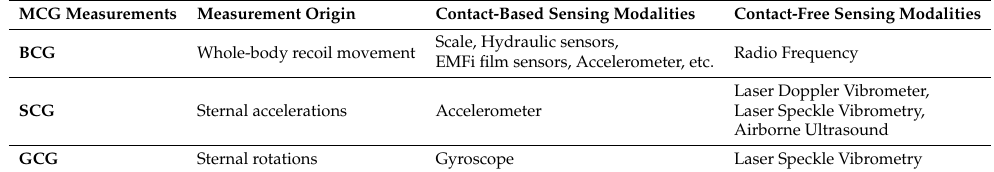
Table 1. Summary of instrumentation for mechanocardiogram